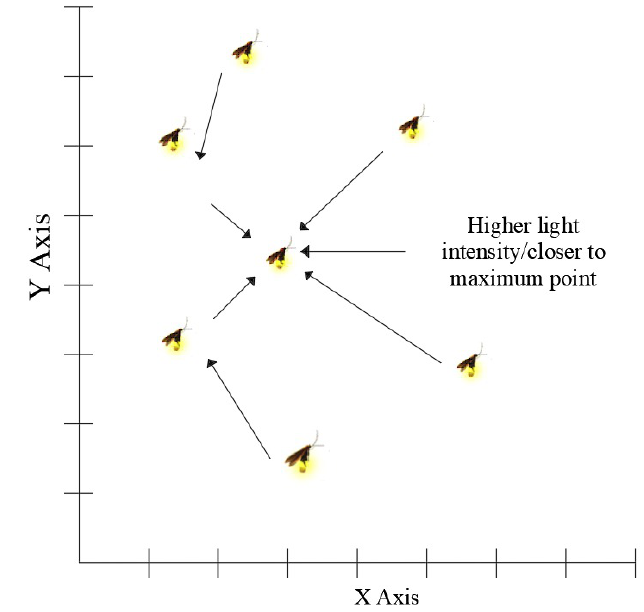
Figure 4. Effect of firefly attraction according to luminosity.